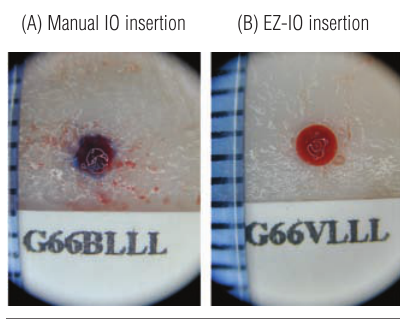
Figure 2A and B. Entry sites in bone samples following IO